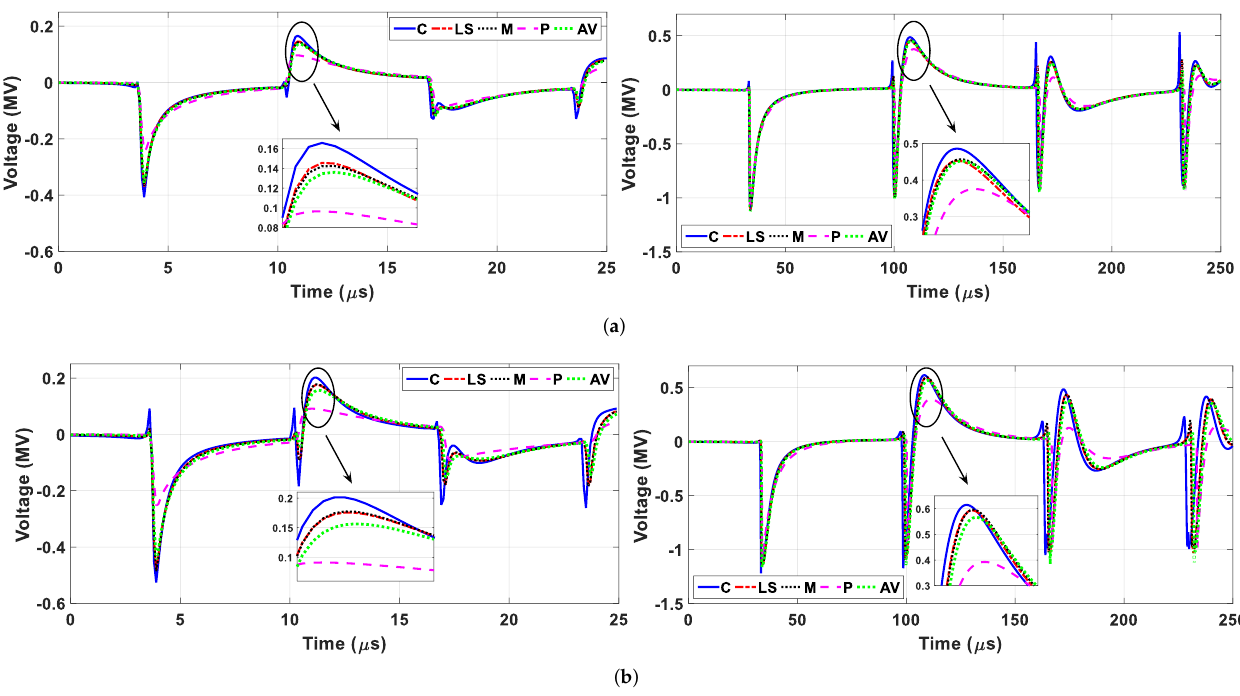
Figure 19. Transient voltages at the receiving end of phase 2 V B lightning direct strike for the 1 km OHTL ( left ) and 10 km OHTL ( right ) with ρ 0 of: ( a ) 700 Ω · m and ( b ) 4000 Ω